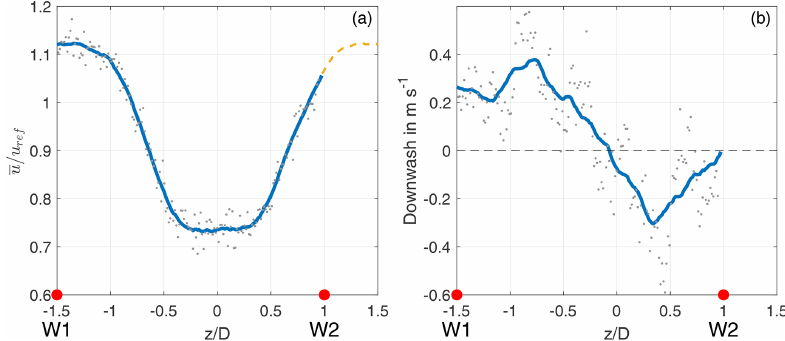
Figure 19. Horizontal cross section at nacelle height through the wake of a wind turbine. (a) Points indicate discretized wind velocity measurements. The line indicates smoothed data (Savitzky–Golay filter). The dashed yellow line indicates missing data. A velocity deficit behind the rotor is clearly visible. (b) Points indicate discretized downwash velocity measurements. The line indicates smoothed data (moving mean). Swirl results in downwash on the left side and upwash on the right side in the wake of the wind turbine. Table 2. Bias and RMSE of the OPTOkopter wind measurements at 10s averaging interval, with the PTB lidar reference. The table includes data from all flights that were done. The distance to the measurement volume of the lidar was difficult to assess, but it was smaller than 10m in all cases. The comparison was done with the OPTOkopter hovering on spot or circling around the lidar measurement volume. Wind speed bias is generally low. RMSEs seem to increase with turbulence